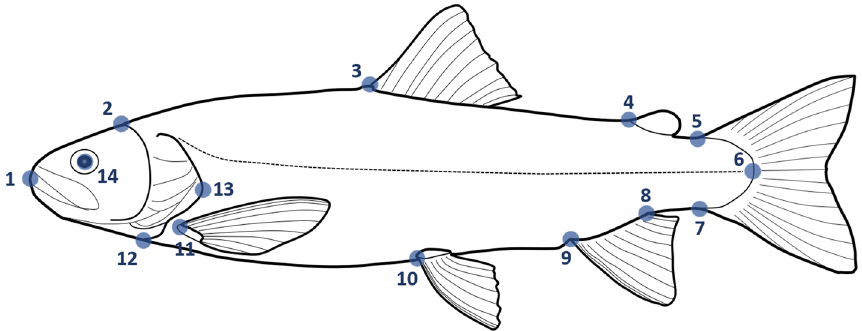
Figure 5. Collection of landmarks used for the morphometric analyses of brown trout shape: (1) tip of upper jaw; (2) posterior supraoccipital notch, (3) anterior insertion of dorsal fin; (4) origin of adipose fin; (5 & 7) anterior junction of dorsal and ventral membrane from caudal fin; (6) intersection of lateral line and membrane of caudal fin; (8 & 9) posterior and anterior insertion of anal; (10) origin of pelvic fin; (11) origin of pectoral fin; (12) ventral insertion between operculum and the body outline; (13) posterior tip of operculum; (14) centre of orbital. Drawing credit: Jorge-Rubén